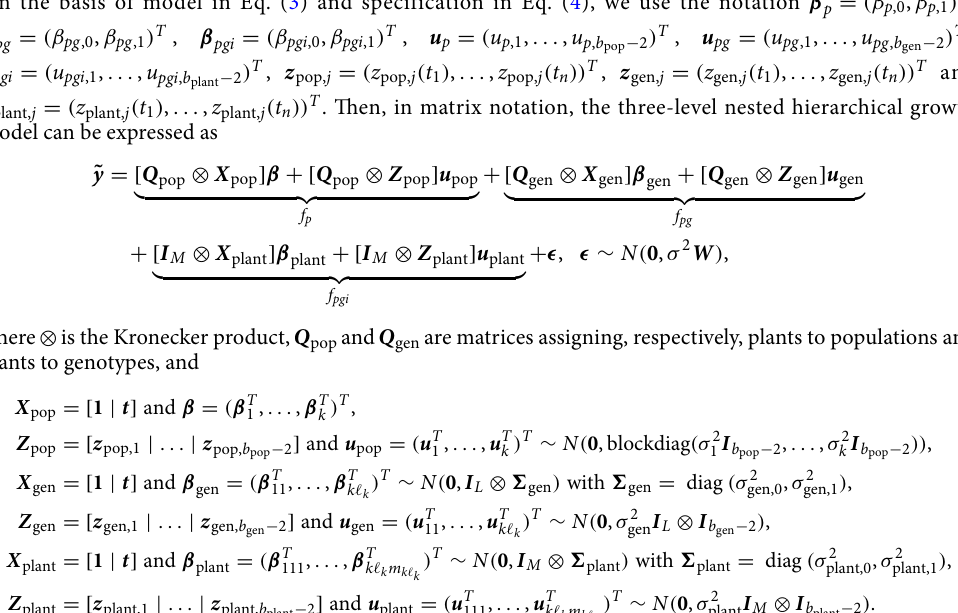
Three‑level nested hierarchical growth model: mixed model